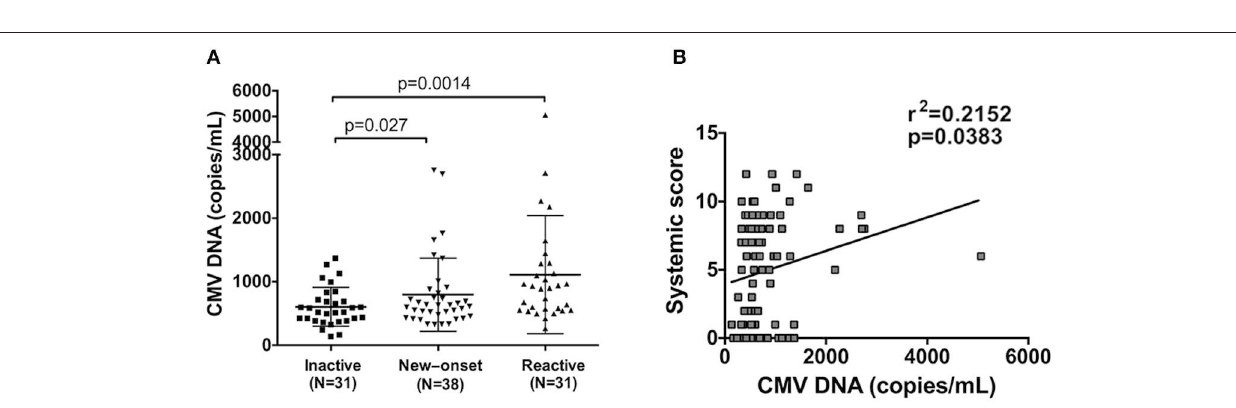
FIGURE 4 | Detection of CMV DNA copy number in AOSD patients. (A) Comparison of CMV DNA copies in patients with inactive ( N = 31), new onset ( N = 38) and active AOSD ( N = 31). (B) Correlation between CMV DNA copy number and AOSD disease systemic score. The data represent the mean ± SD by Student’s t -test in (A) . The correlations were evaluated with Spearman’s non-parametric test in (B) . p < 0.05 represents a significant